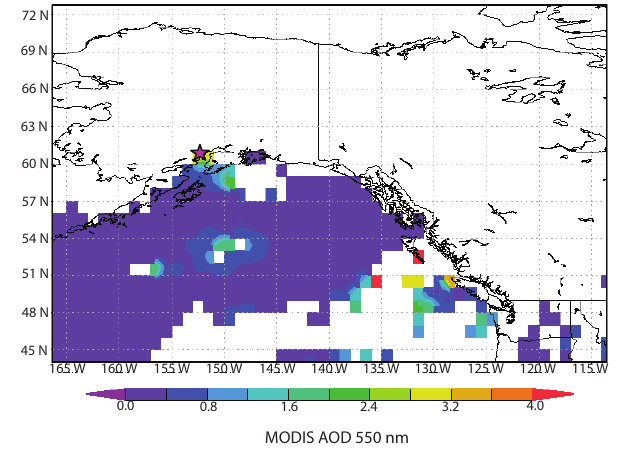
Fig. 6. MODIS AOD(550nm) daily average for 27 March. These AOD values were the highest over the entire course of the explosive eruptions, due to aerosol produced by the very powerful eruption at 17:24UTC on March 26 and the eruptions that followed on 27 March.